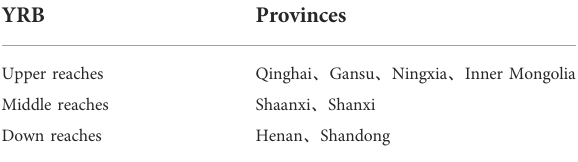
TABLE 1 Provinces in the upper, middle and down reaches of the YRB. YRB